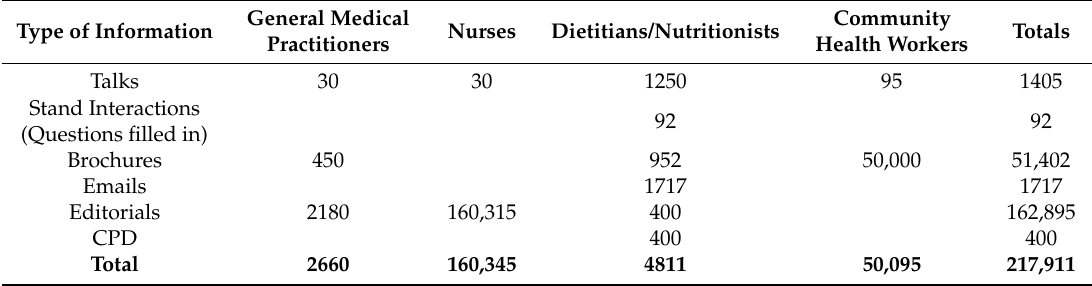
Table 1. Information regarding the Salt Watch campaign shared with health care